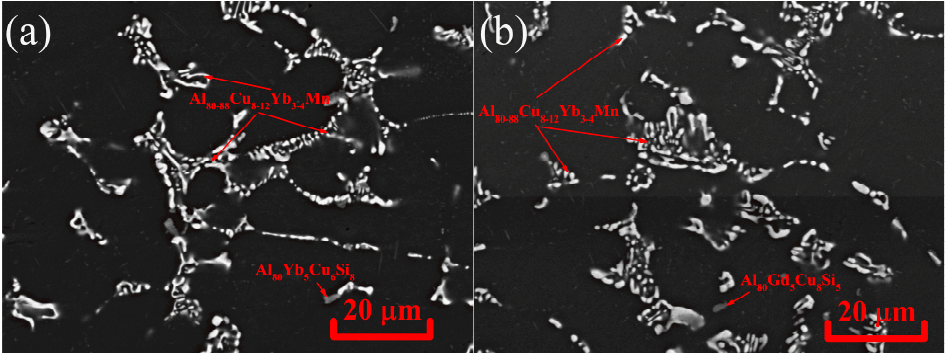
Figure 4. Microstructures of the ( a ) AlCuYbMg and ( b ) AlCuGdMg alloys after 3 h of solution treatment at ( a ) 555 °C and ( b ) 565 °C (SEM-BSE) . Table 3. Composition of the Al solid solution after 3 h of solution treatment .